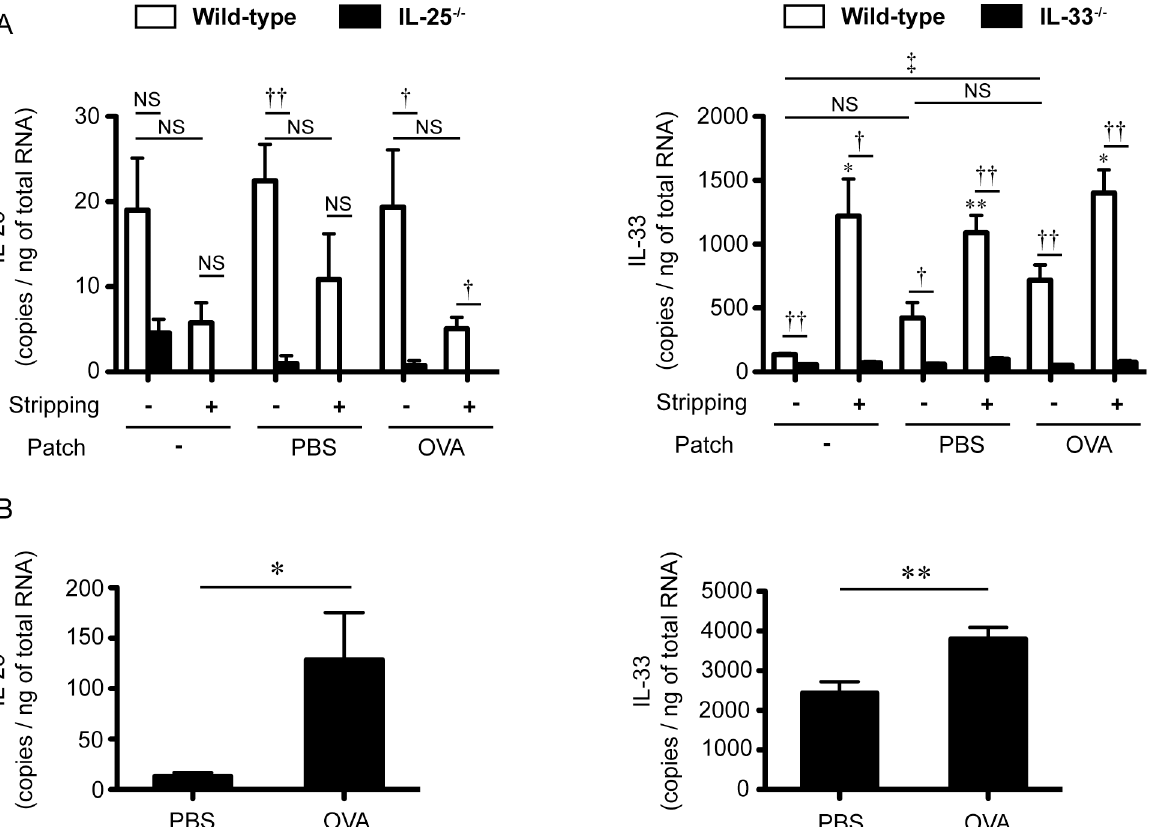
Fig 1. Expression of IL-25 and IL-33 mRNA in the skin after tape-stripping and in the lungs after antigen challenge. Dorsal skin was collected from wild-type (WT) mice, IL-25 -/- mice and IL-33 -/- mice 6 hours after tape-stripping followed by with or without a patch containing PBS or OVA, while lungs were harvested from WT mice sensitized EC with OVA 24 hours after the last intranasal challenge with OVA. mRNA was isolated from the skin and lungs, and the expression levels of IL-25 and IL-33 mRNA were determined by quantitative PCR. (A) The IL-25 and IL-33 mRNA expression levels in the skin (n = 3 – 5). * P < 0.05 vs. the corresponding values for a group without stripping (a group without stripping vs. a group with tape-stripping). ‡ P < 0.05 vs. the indicated group (a group without stripping and patch vs. a group without stripping and with patch containing OVA). † P < 0.05 and †† P < 0.01 vs. the indicated